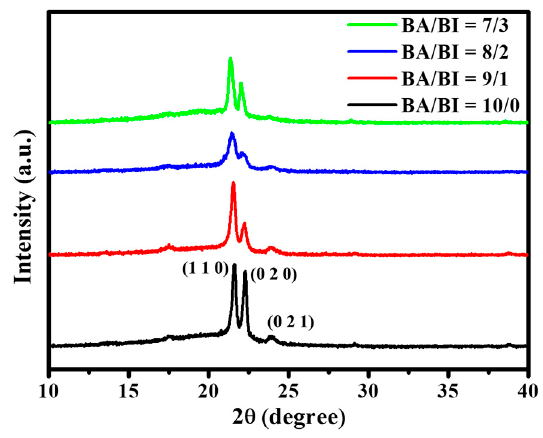
Figure 6. X-ray di ff raction of the PBABI Figure 6. X-ray diffraction of the PBABI copolyesters.